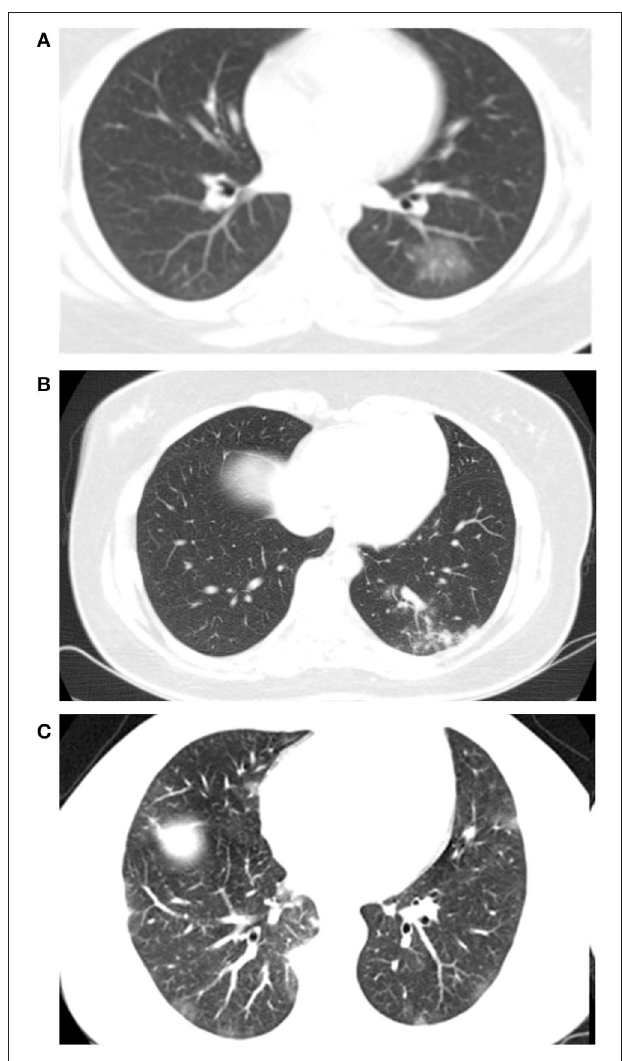
FIGURE 3 | Patients chest CT showing coronavirus disease 2019 reporting and data system (A) CORADS 3. (B) CORADS 4. (C) CORADS 5.